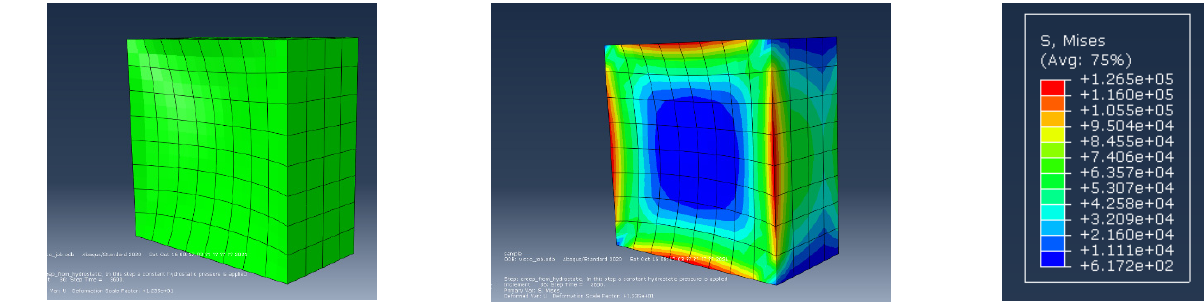
Figure 9. FEM analysis of SPRG based on applicable hydrostatic